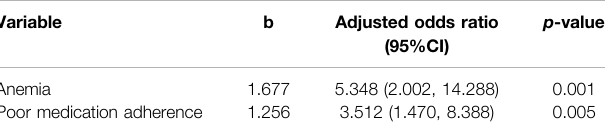
Multiplestepwiselogisticregressionwasperformedwithadjustmentofgender,ethnicity, age, baseline eGFR, albuminuria, diabetes mellitus, hypertension, dyslipidemia, spironolactone use, and recessive model of CYP3A5*3 polymorphism. Multicollinearity and interaction term were not found. Model fi t was examined using the Hosmer – Lemeshowtest( p =0.995),classi fi cationtable(84.4%),andareaunderreceiver